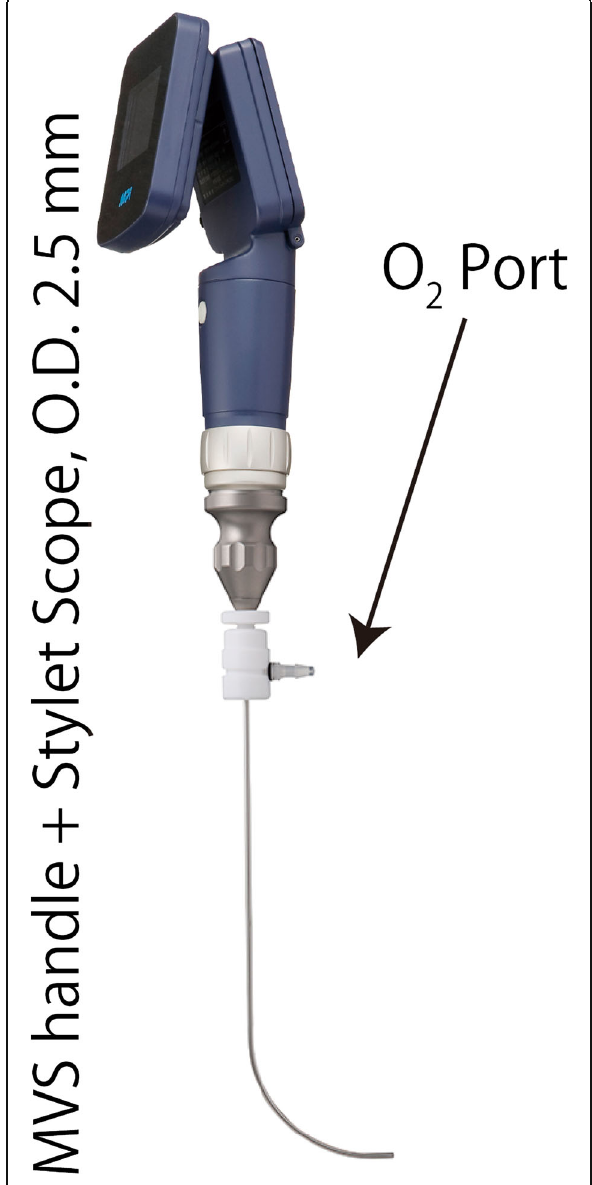
Fig. 1 MultiViewScope (MVS) system. The stylet scope was attached to the video monitor